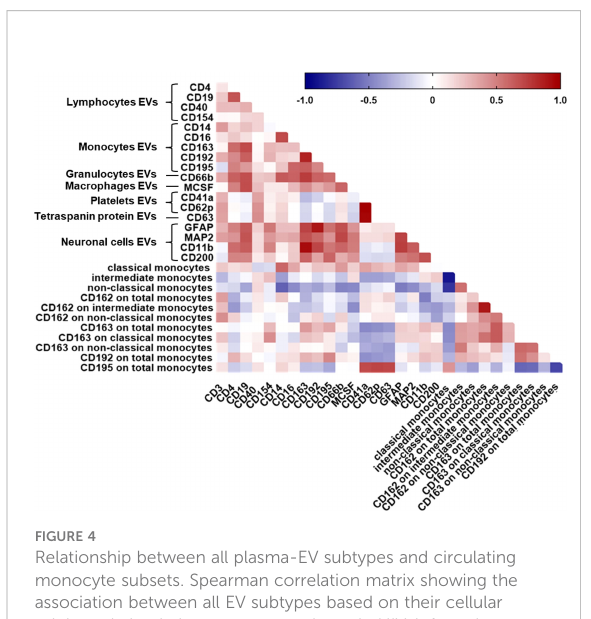
FIGURE 4 Relationship between all plasma-EV subtypes and circulating monocyte subsets. Spearman correlation matrix showing the association between all EV subtypes based on their cellular origin and circulating monocyte subsets in HIV-infected individuals on ART. Positive correlations are displayed in red shades and negative correlations are in blue